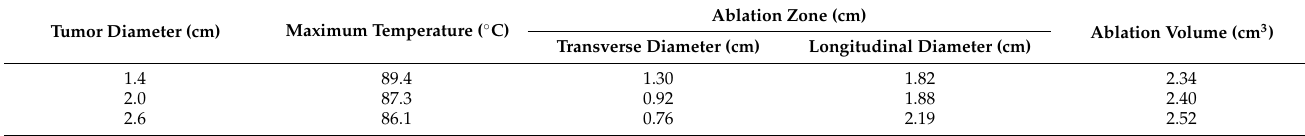
Table 5. Ablation temperature, ablation area and ablation volume for different diameter tumors.